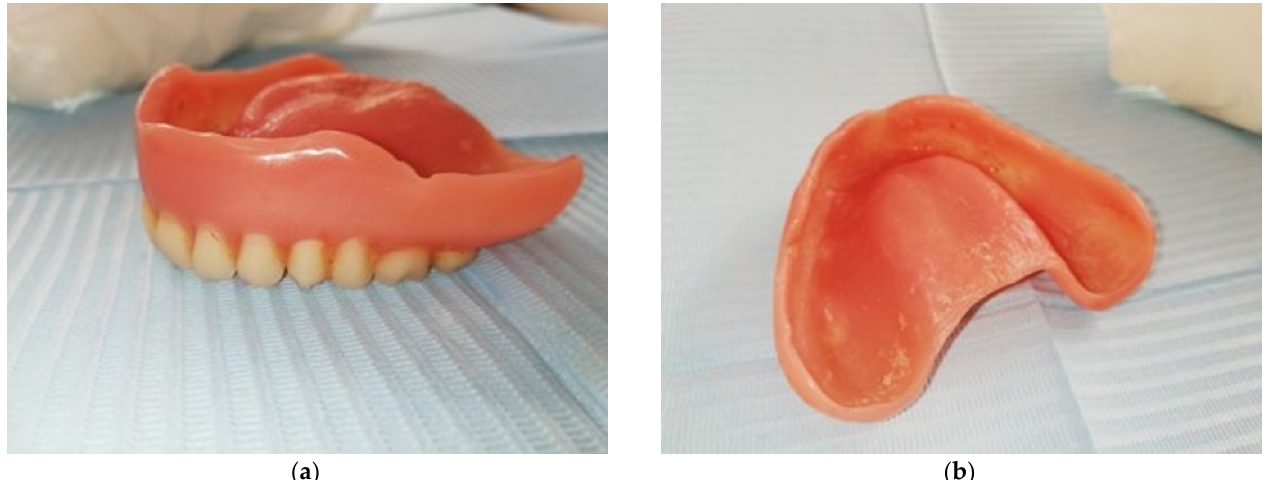
Figure 4. Maxillary denture about 10 years old ( a ) lateral view ( b ) mucosal view.